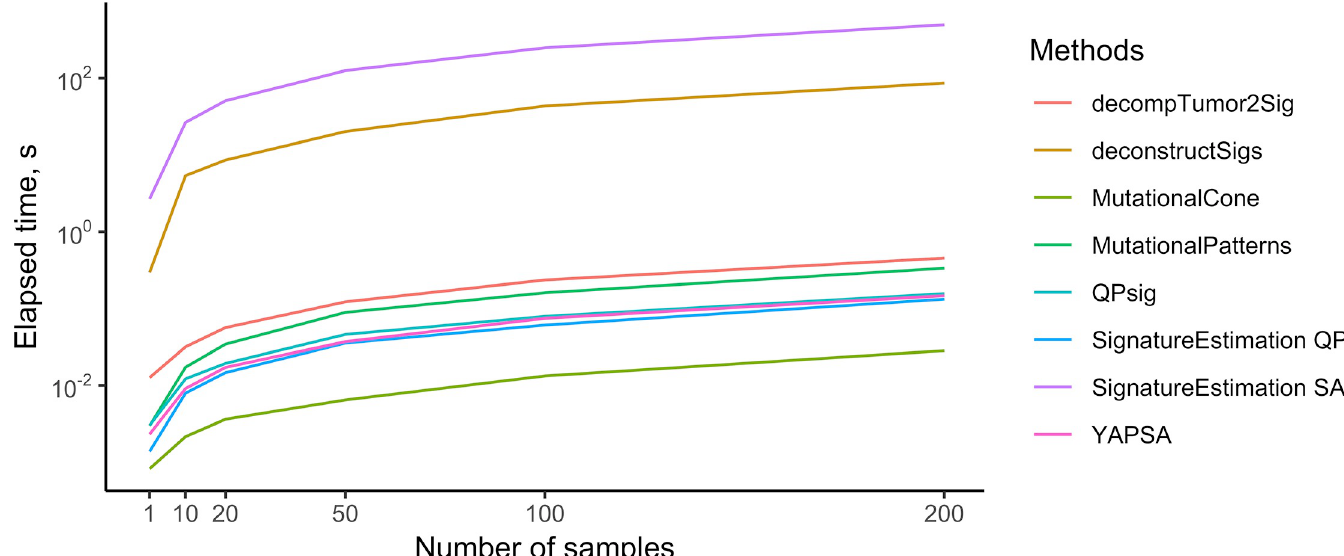
Fig 10. Running times of refitting tools. Methods were applied to subsets of the TCGA Lung cohort of different sizes. The y-axis is in logarithmic scale.